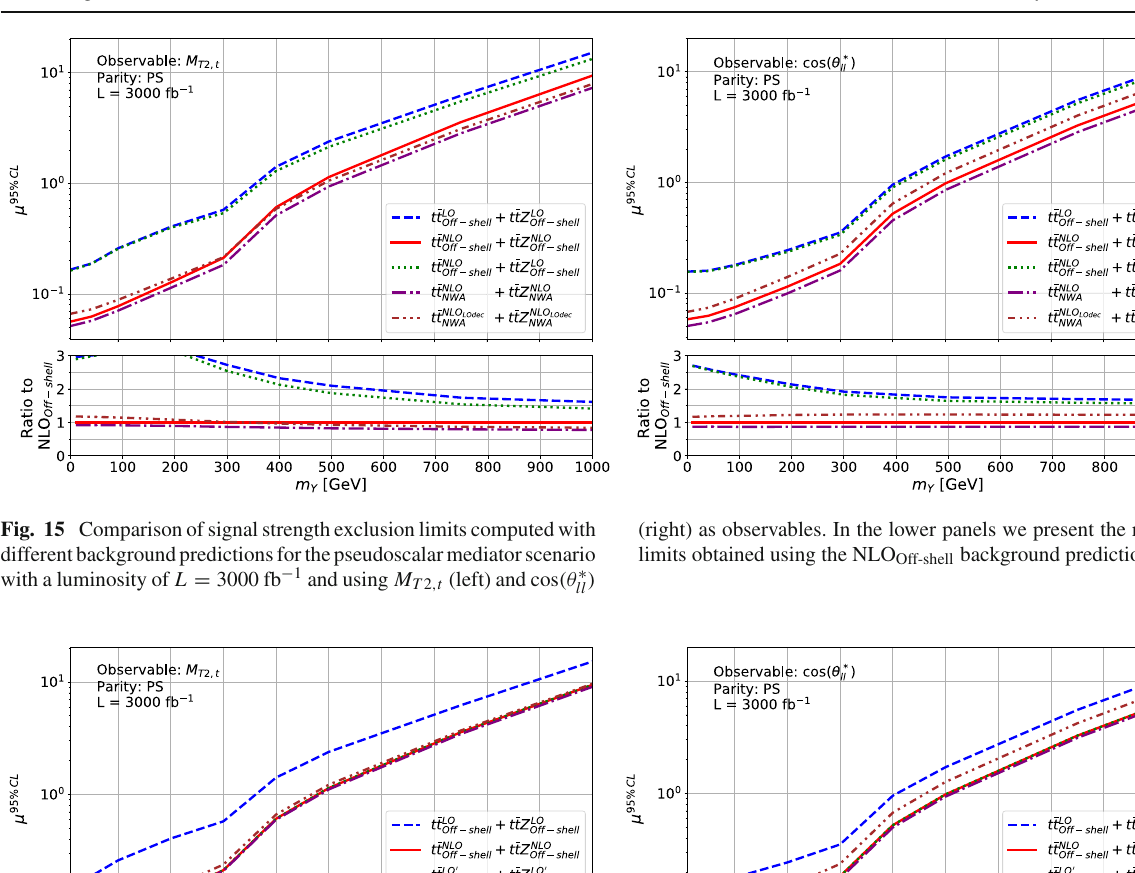
t ¯ tZ results in the NWA to eliminate the effect from the missing t ¯ t con- tribution. In the lower panels we present the ratios to the limits obtained ) using the NLO Off-shell background predictions ll